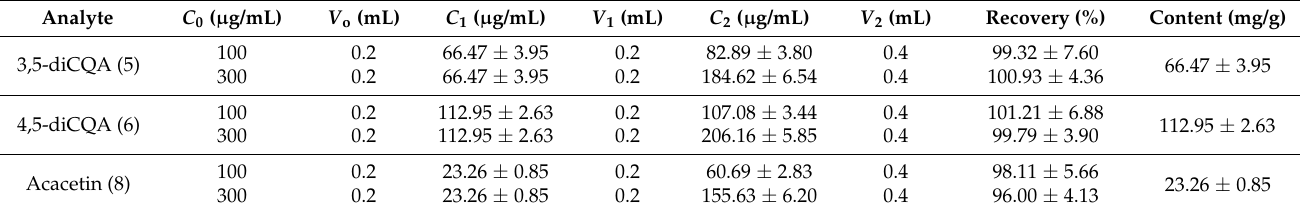
Table 7. The spike recovery test and content of the three major compounds in the 70% MeOH root extract of V. rigida .